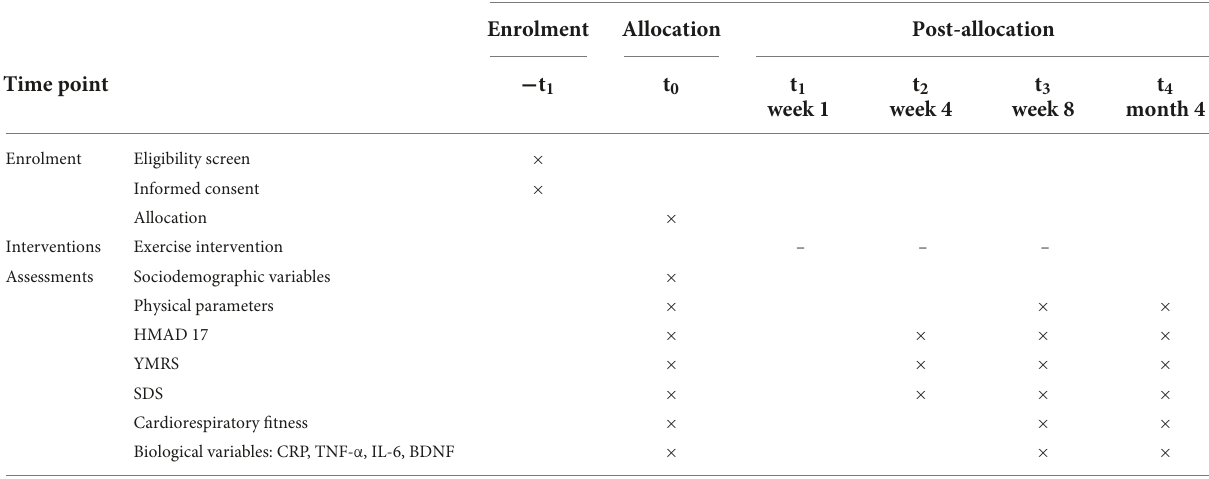
TABLE 1 Schedule of the enrollment, intervention, and